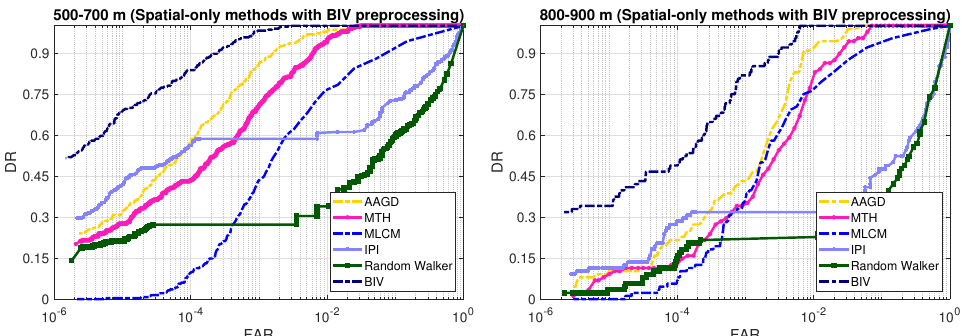
Figure 11. Detection results of the spatial-only approaches where the input images are preprocessed with the first two stages of the BIV target detector. The BIV preprocessing has significant increased the performance of these methods compared to their raw input versions (Figure 10). In spite of the improvement gained by using the BIV pre-processing, the existing methods are still out performed by the BIV target detector at both ranges.